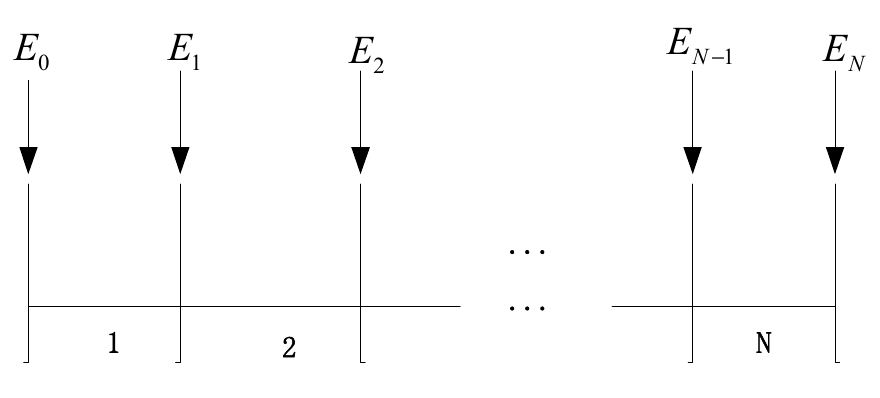
Figure 2. The renewable energy of battery.